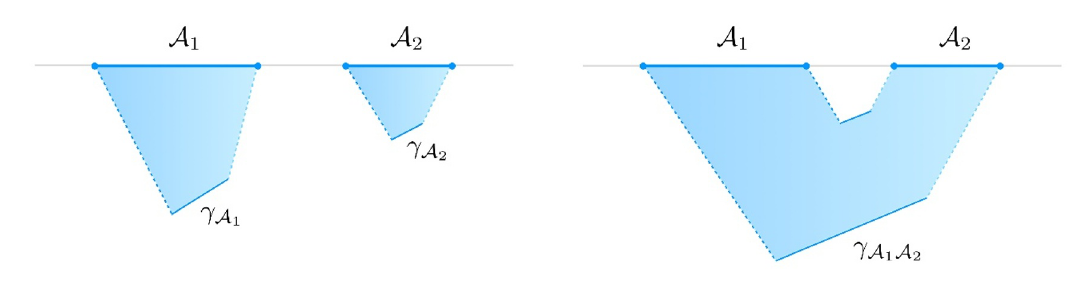
∪ γ A and γ A homolo- 1 2 1 A 2